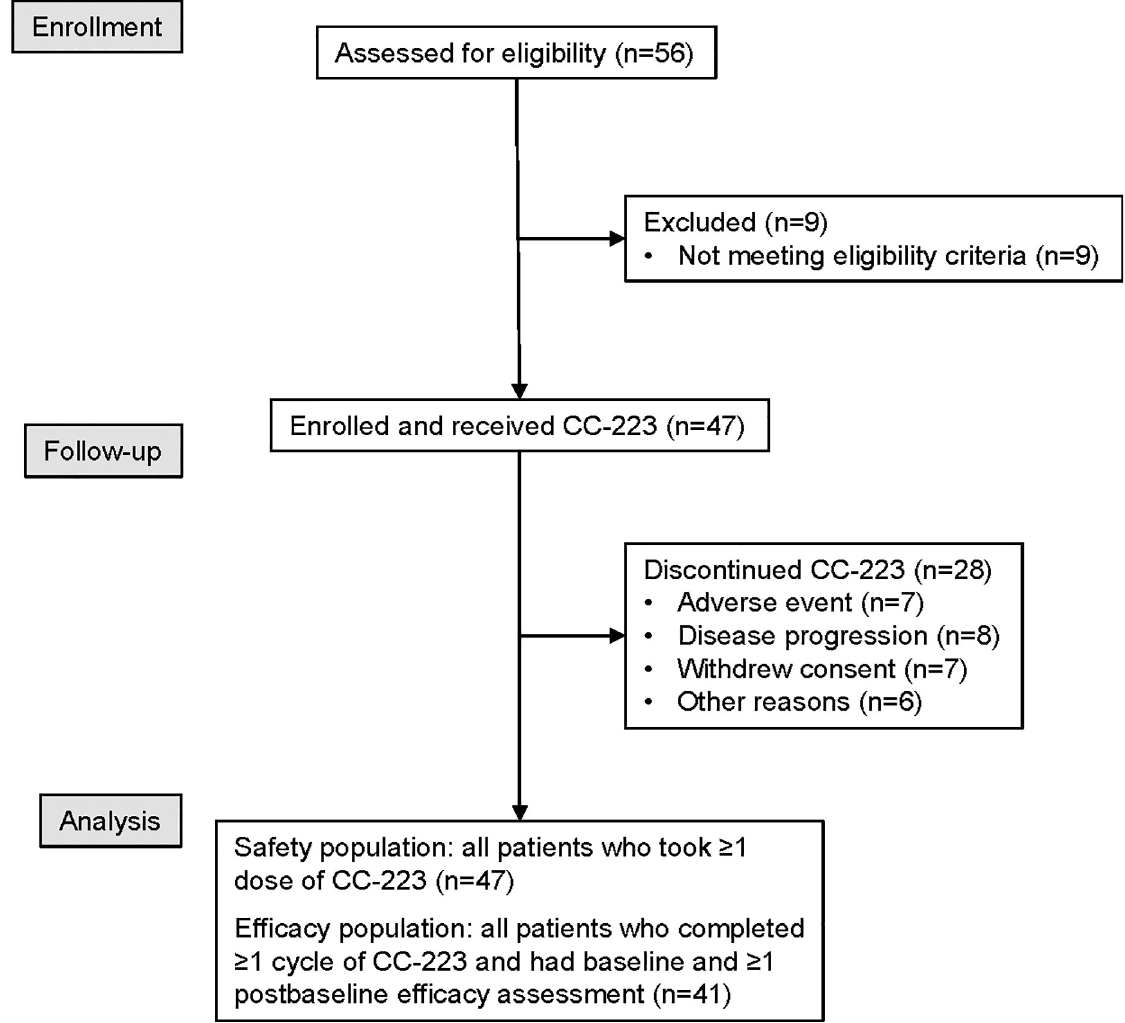
Fig 1. CONSORT diagram. immunoglobulins including T-cell subsets (CD4+ and CD8+). We also performed serial tripli- cate electrocardiograms (ECGs), periodic left ventricular ejection fraction estimations (echo or multiple gated acquisition [MUGA]), regular physical exams and vital sign measurements (heart rate, blood pressure, respiratory rate, and temperature). Adverse events were coded with Medical Dictionary for Regulatory Activities (MedDRA) version 19.0. Severity of adverse events was classified using the National Cancer Institute Common Terminology Criteria for Adverse Events (CTCAE) version 4.0. A safety review committee provided study oversight. Tumors were restaged by the principal investigator at each site using computed tomogra- phy (CT), positron emission tomography (PET)-CT, or magnetic resonance imaging scans after every 2 cycles through cycle 6, and every 3 cycles thereafter, using Response Evaluation Criteria In Solid Tumors (RECIST) version 1.1 criteria for response [14]. Metabolic changes were assessed by percent change in total of standardized uptake value (SUV) of 2- 18 F-fluoro-2-deoxyglucose (FDG) with PET scanning from baseline to day 15 in cycle 1. Carcinoid symptoms of flushing and diarrhea were documented monthly with a non-